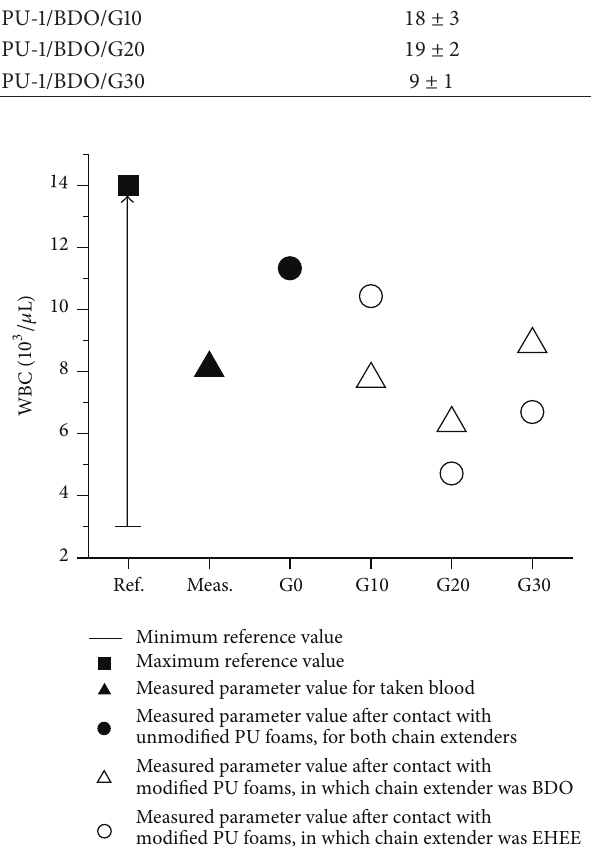
Figure 7: WBC value, for all investigated samples, which stays in the reference